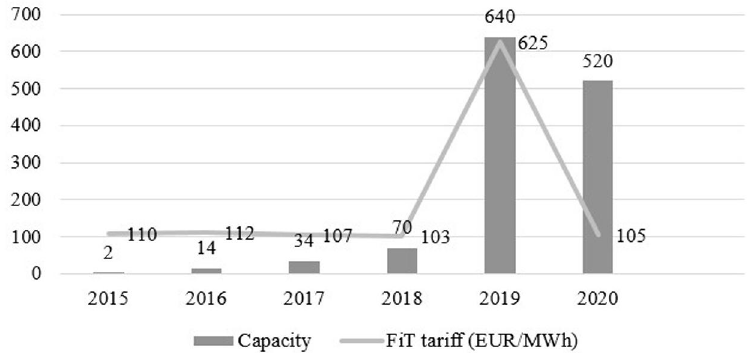
Figure 5. The total capacity of wind farms and the FiT tariff of multinational corporations (study sample). Source: calculated on the basis of data from official reports of multinational corporations and consulting agencies [21,29–33].